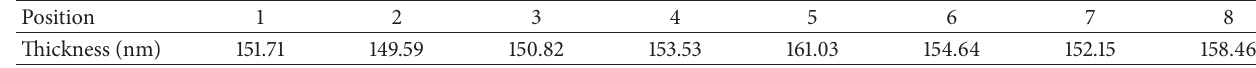
Table 2: Thickness of the “Alq3” thin films deposited by the planar source.